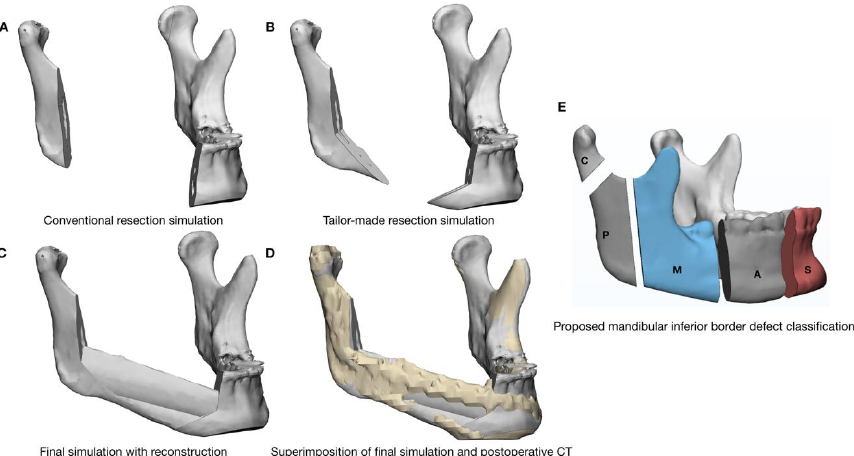
Figure 2. Evaluation methods of surgical outcomes. ( A ) The volume and surface of conventional resection and ( B ) tailor-made resection simulation are automatically calculated using medical computer-aided design software; ( C ) final simulation with reconstruction is compared to ( D ) postoperative computed tomography (CT). Then, (D) is compared to (A) to evaluate preservation of the mandibular anatomy structures; ( E ) Proposed new mandibular border defect classification.